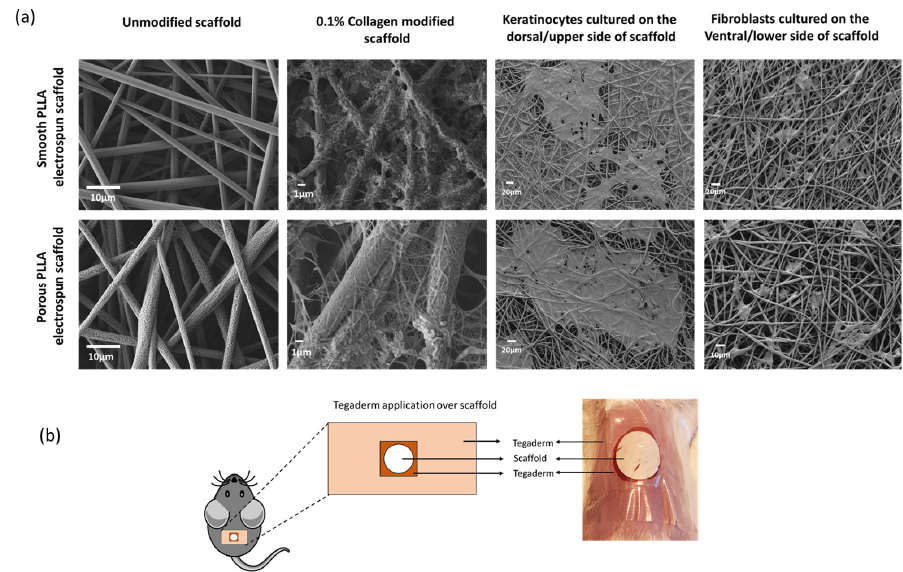
Figure 1. Collagen functionalization of polymeric electrospun scaffolds for wound healing applica- tions. ( a ) SEM micrographs depicting the morphological features of unmodified smooth and porous, collagen-modified smooth and porous electrospun scaffolds and co-cultured skin cells on electrospun PLLA scaffolds on collagen-modified porous and smooth scaffolds. ( b ) Prepared 10 mm-diameter scaffolds were applied to the centre of full ‐ thickness excisional mouse wounds and covered with the Tegaderm film as illustrated in the schematic and in the photograph.